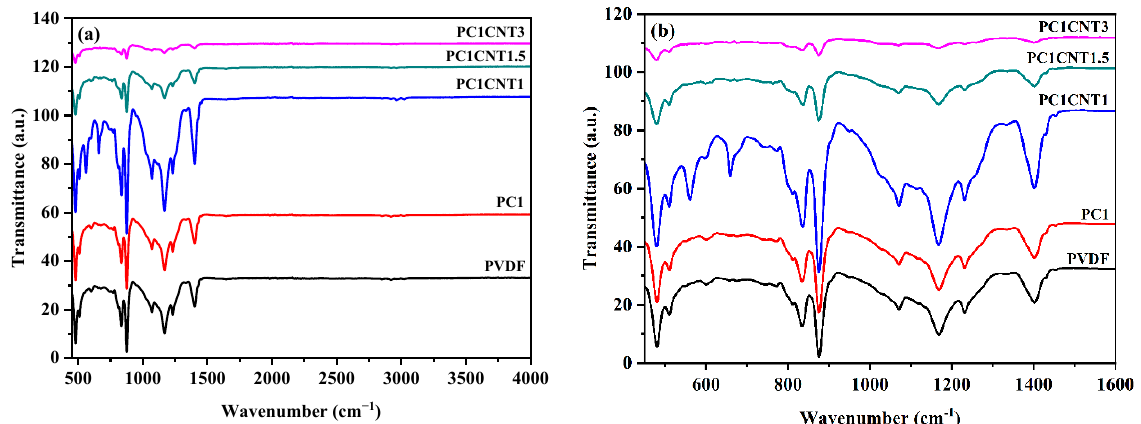
Figure 5. FTIR spectra of pure PVDF and its nanocomposites in the range of 4000 cm − 1 –450 cm − 1 ( a ), and 1600 cm − 1 –450 cm − 1 ( b ).